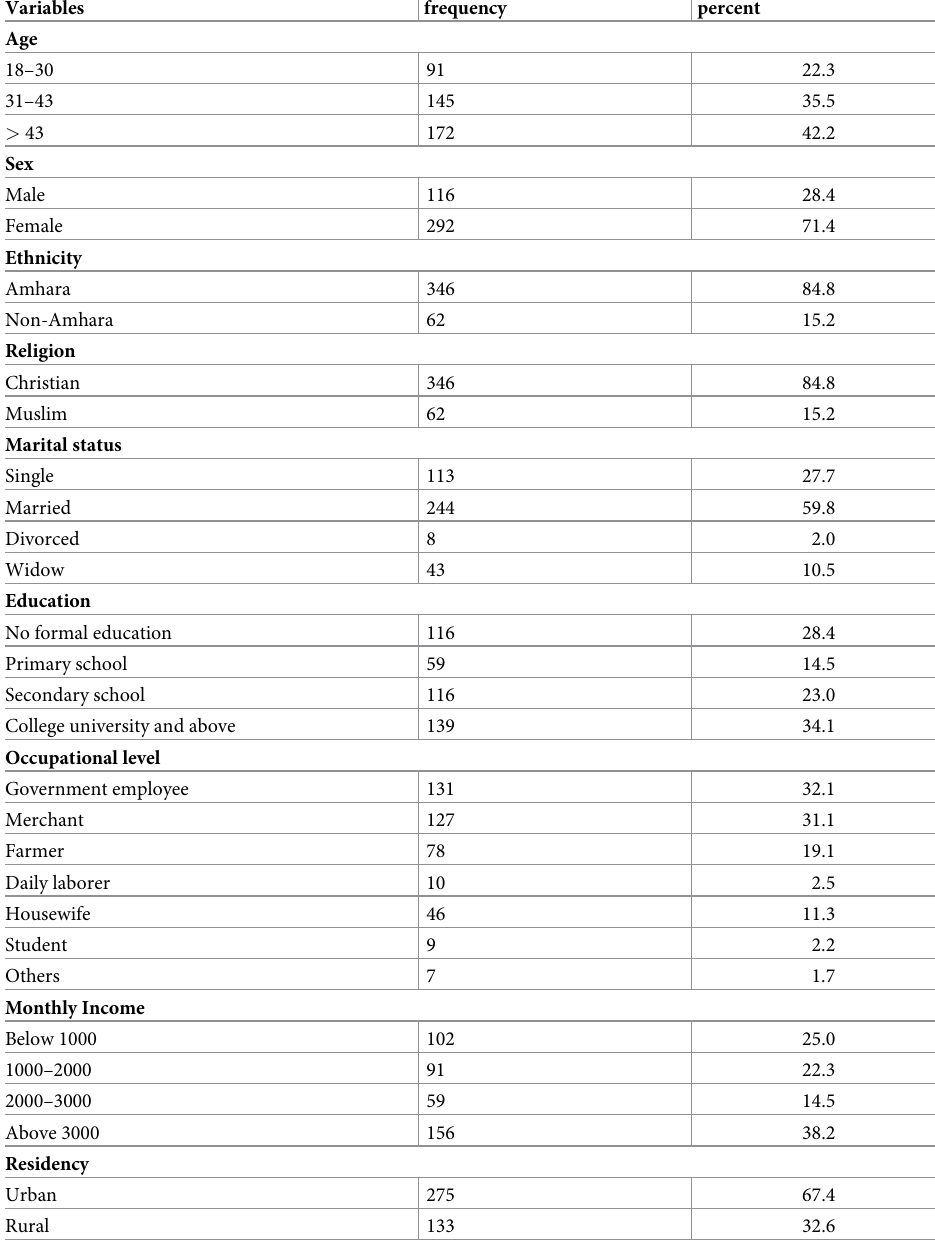
Table 1. Sociodemographic characteristics of patients attending Gondar University Comprehensive and Special- ized Hospital, July 2020.